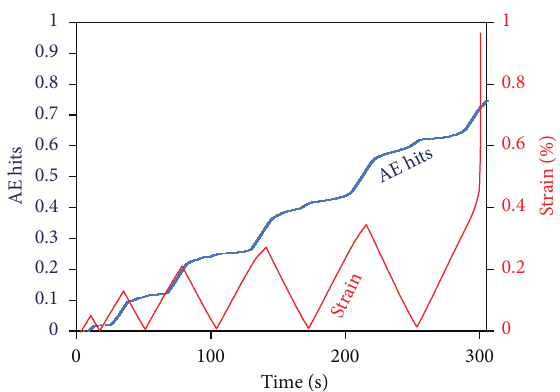
Figure 12: Strain history and AE peak frequency for a double-edge notched specimen with notch-to-width ratio of 0.35. The solid line is the sliding average of recent 20